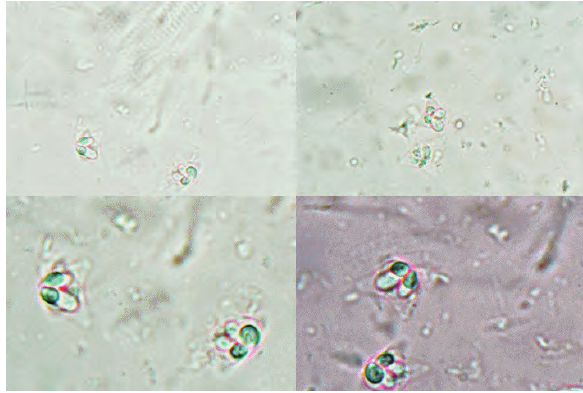
Figure 2: Light micrographs (1000X magnification, Olympus CX31, Nikon DS-Fi1 camera, Nikon NisElements Imaging software version 3.22) of Kudoa thyrsites spores from infected Cape dory ( Zeus capensis )